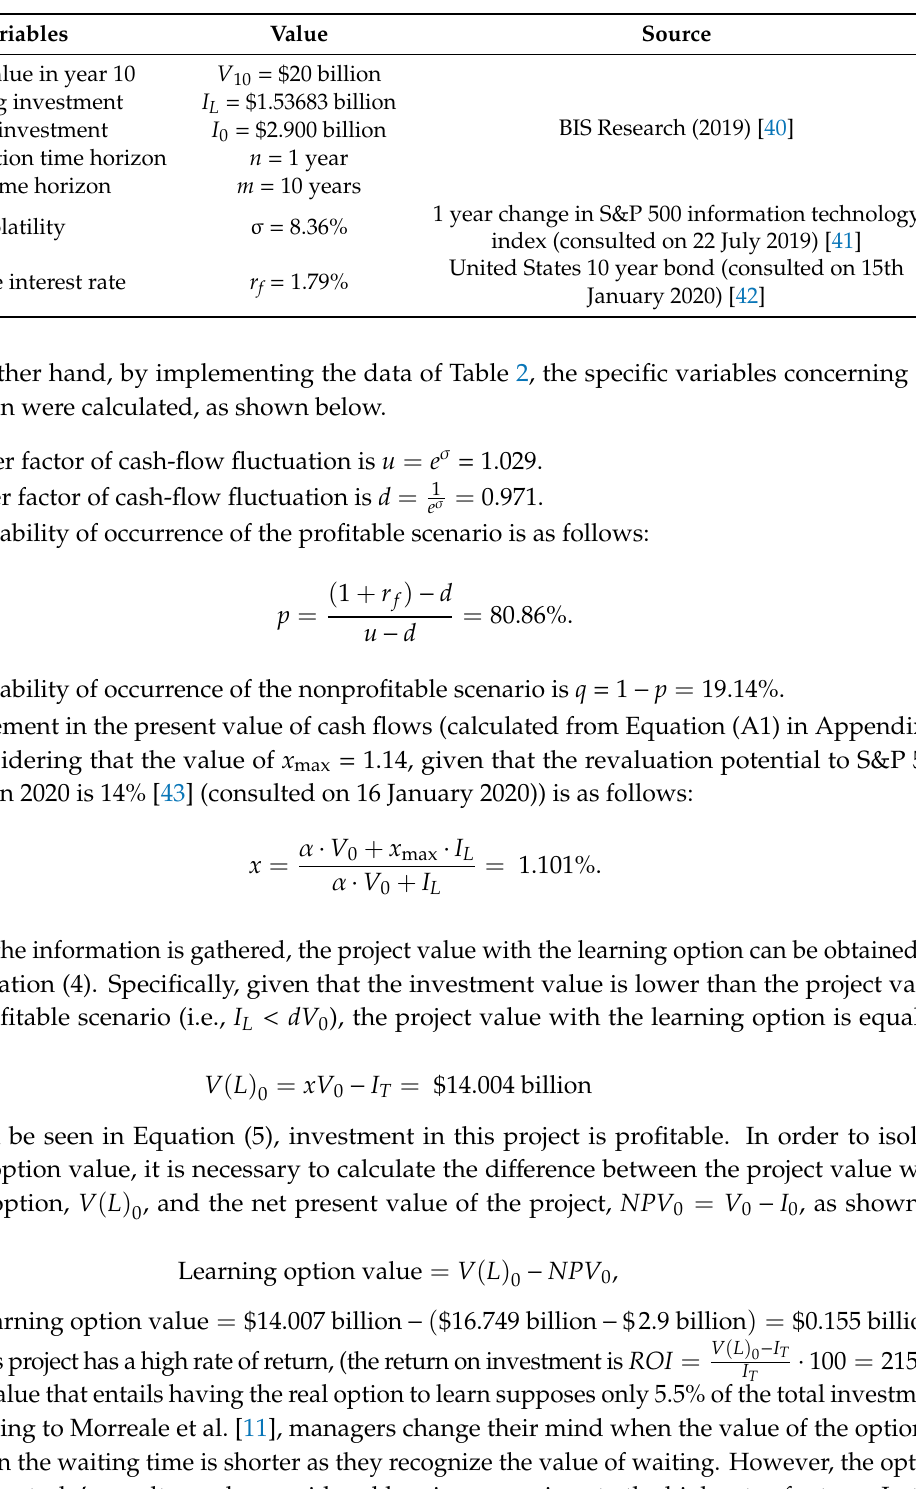
Table 2. Variables used for applying the real options model (source: own